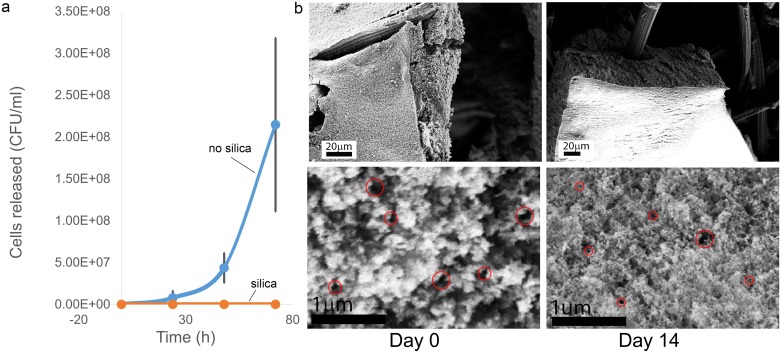
Silica filter characterization.(a) The effectiveness of silica in containing bacteria is tested by CFU tests with samples taken at t = 0, 24, 48, and 72 hours. The bare electrode (blue) shows leakage of bacteria through the electrode whereas the silica on the coated electrode (red) acts as a filter, preventing this contamination. (b) Scanning electron micrographs (SEM) of electrode surface showing the silica coating (1μm thick, 2 hour deposition) and further magnification to determine that there is evidence for pores with <0.2μm (samples circled in red), and the absence of >2μm pores taken at t = 0 and t = 14 days. Absence of significant visual discrepancies indicates the coating does not degrade over the lifetime of these experiments.